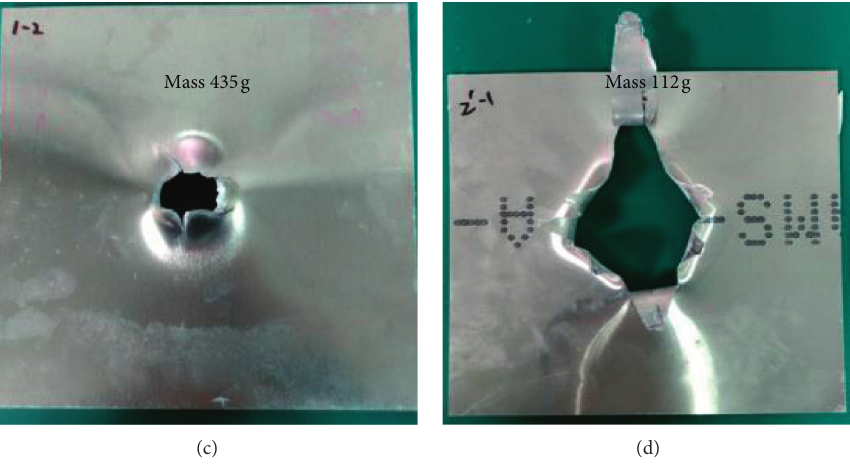
Figure 16: Mass of the aluminum alloy backplate after the ballistic experiments. (a) 10% 333 FGM + 4mm Al backplate. (b) 10% 333 FGM +